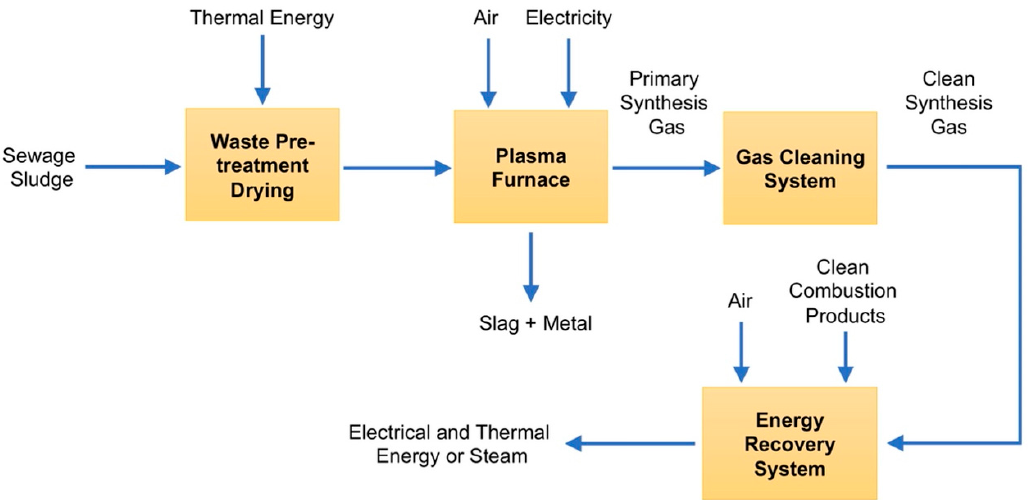
Figure 8. Block diagram of syngas production from sewage sludge using plasma reformer technology, prepared on the basis of the data contained in [60].